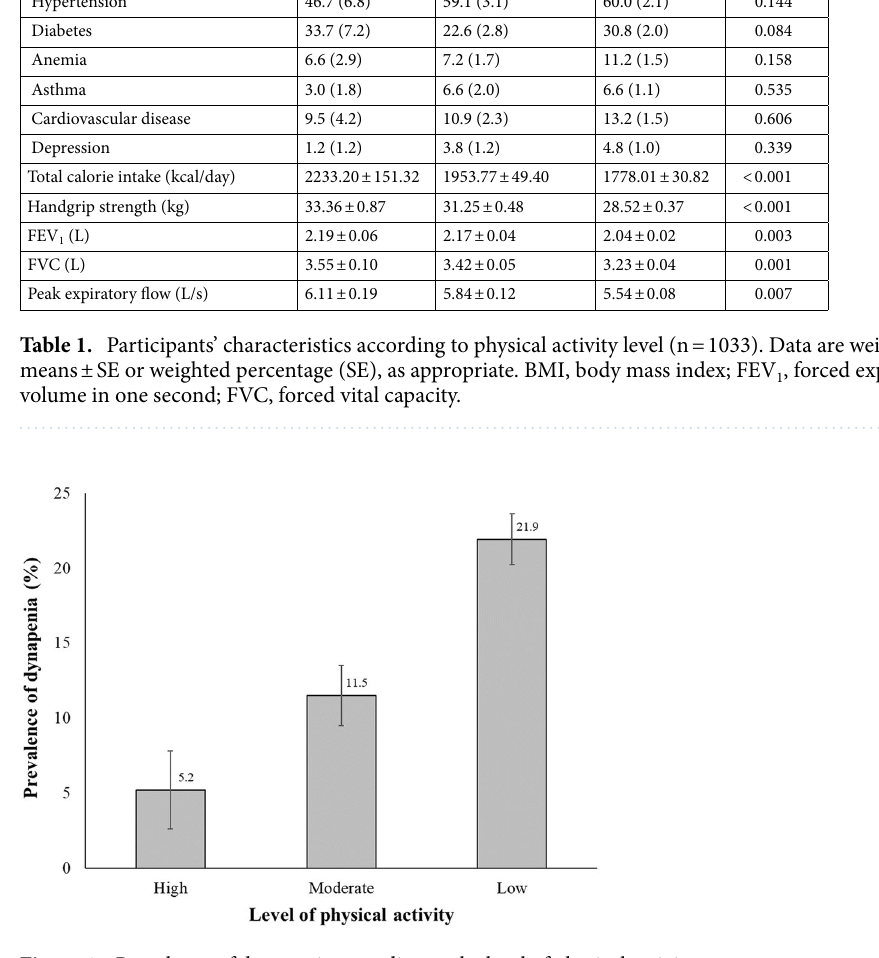
Figure 1. Prevalence of dynapenia according to the level of physical